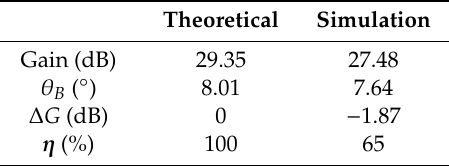
Figure 18. Abbe’s sine shaped lens performance. Table 9. Simulation results.